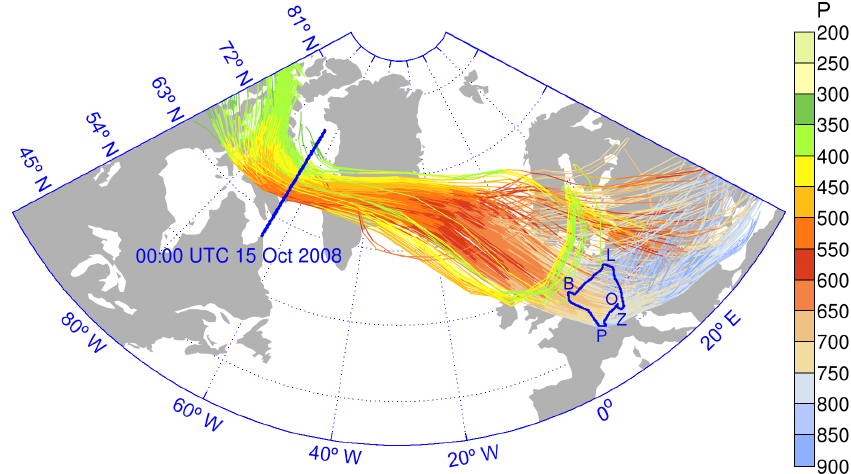
Figure 1. LAGRANTO 5-day forward trajectories from the full set calculated that fulfil both the deep-STT criterion and a passage above the blue line along the 65 ◦ W meridian within ± 6h of 15 October 2008, 00:00UTC. The pressure level (in mbar) is colour coded. The blue contour around a major part of central Europe visualizes the flight track of the DLR Falcon jet from Oberpfaffenhofen (O, south-west of Munich) to the four stations Payerne (P), Bilthoven (B), Lindenberg (L) and Zugspitze (Z), and